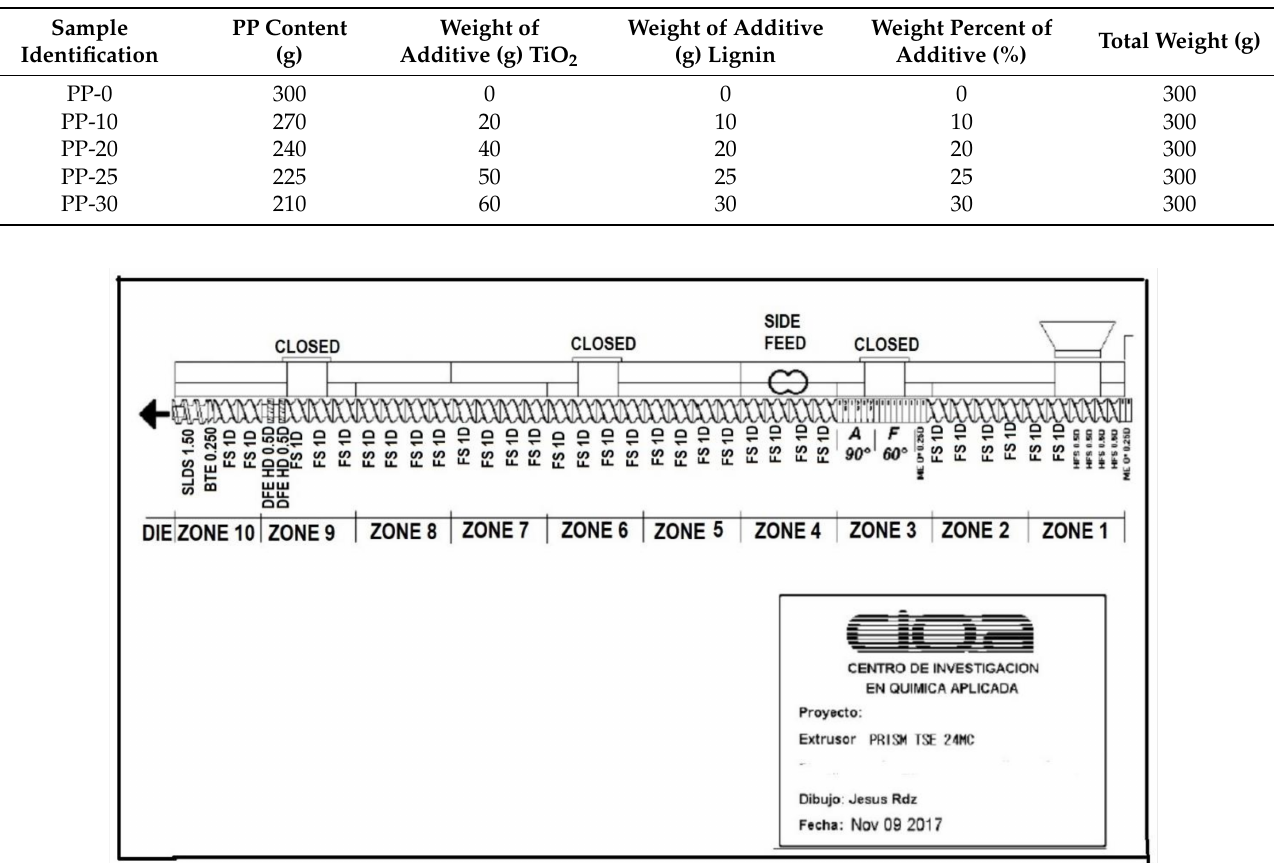
Figure 1. Screw mixing settings used during